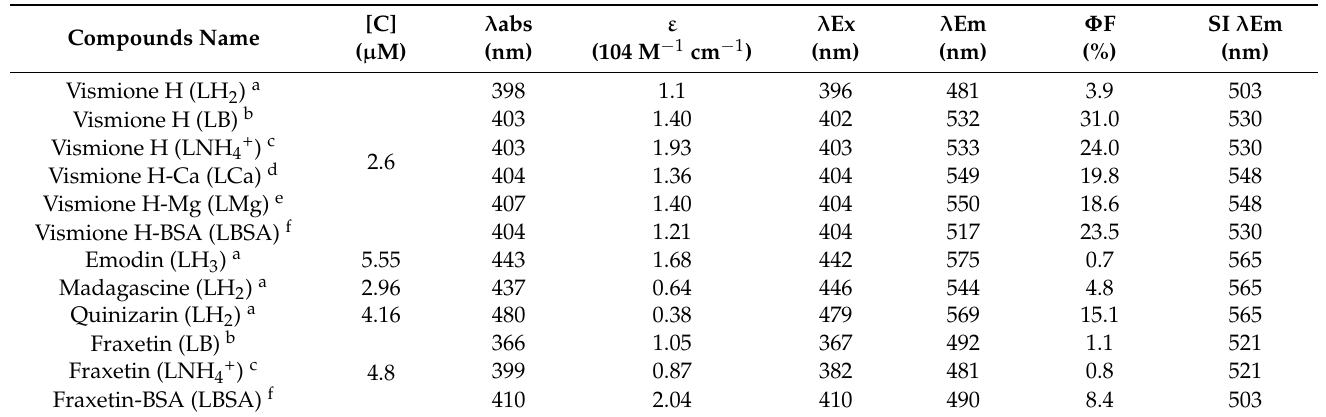
Table 1. Main photophysical characteristics of fluorescent